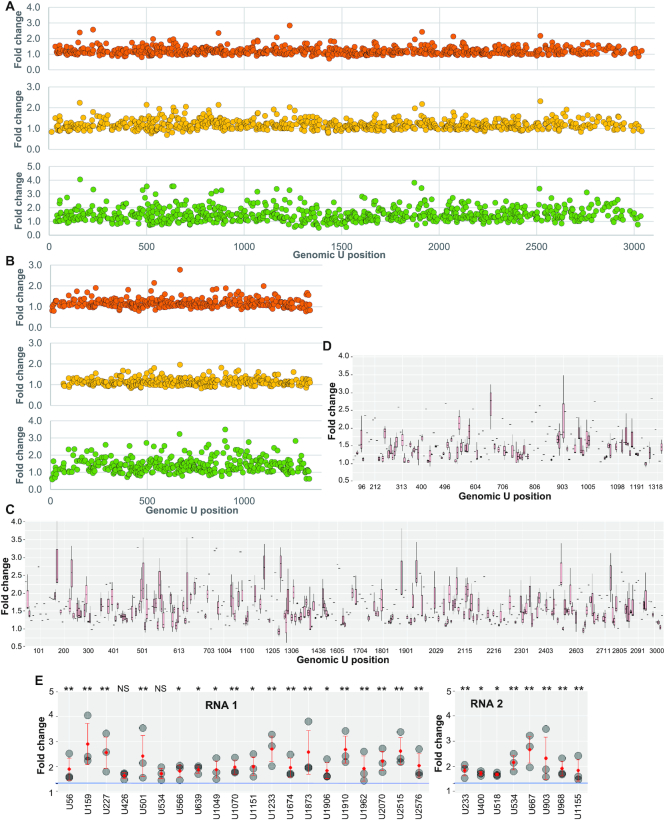
Consistent vPAR-CL sites revealed clear RNA tropism in FHV virion. Biological triplicate FHV vPAR-CL experiments, with signals plotted for (A) RNA 1 and (B) RNA 2. Biological triplicates’ vPAR-CL signals were box-plotted for (C) RNA 1 and (D) RNA 2. Signals below background threshold were removed, which resulted in vacant or singular signals over certain genomic positions. A number of sites on both RNA 1 and RNA 2 retained substantial signals in all triplicates, indicating replicable crosslinking sites between RNA and capsid. These consistent vPAR-CL sites also suggest a conserved tropism of FHV RNA cage inside virion. X-axis is not continuous. (E) Among these consistent vPAR-CL sites, most of them showed significantly higher vPAR-CL signals than the average. Grey circles: vPAR-CL signals of each biological replicate; red dots: mean signals. Blue line: average vPAR-CL signal of RNA 1 and RNA 2, respectively. *P < 0.05; **P < 0.01; NS = not significant. Statistical assays were conducted with standard t-test (two-tailed).